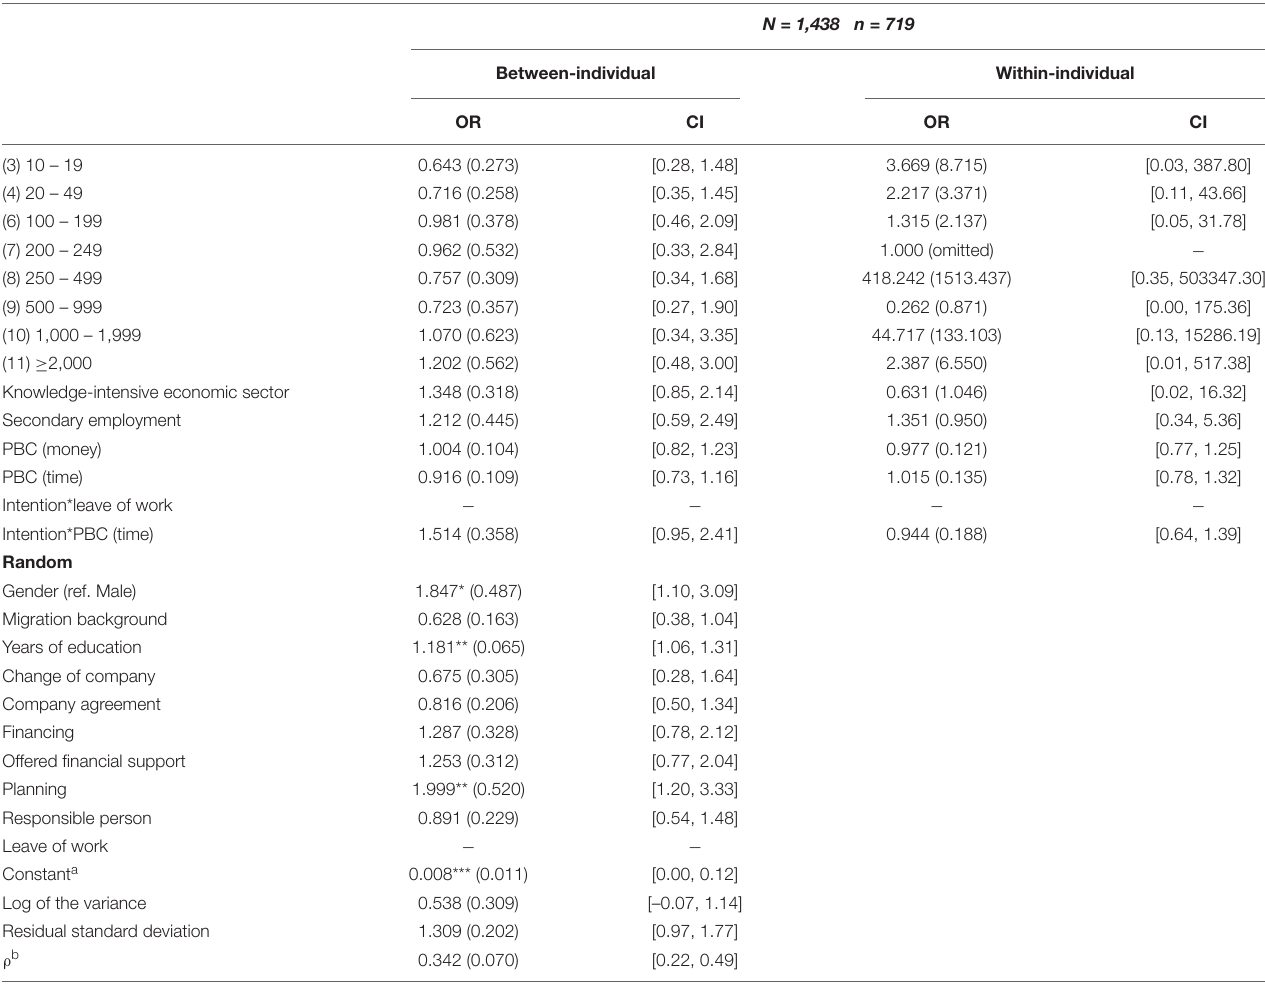
TABLE 6 | Results (Hypothesis 4 – subsample of individuals who were offered a leave of work).